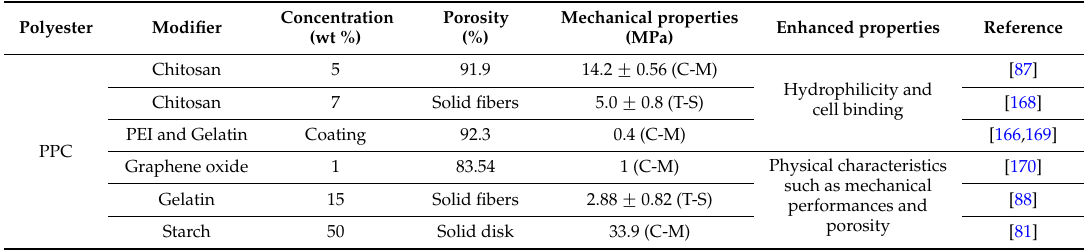
C-M: Compressive modulus; T-S: Tensile